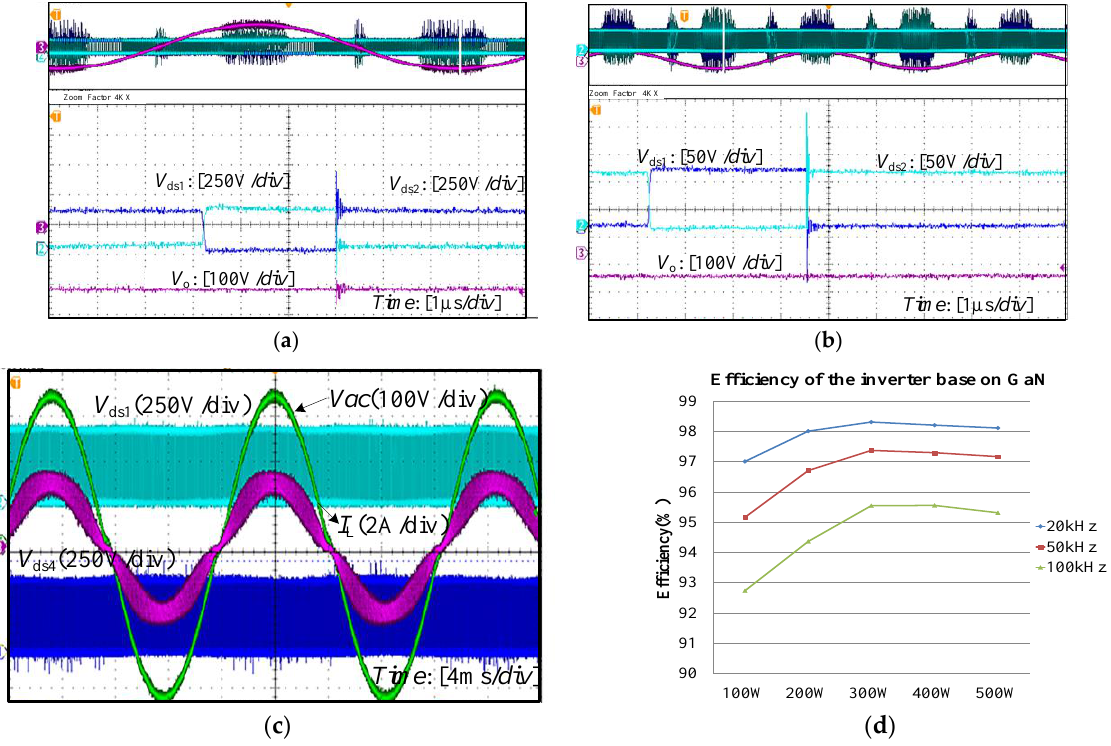
Figure 7. Experiment results of the cascode GaN HEMT-based single-phase inverter. ( a ) Experiment results of the cascode GaN HEMT-based inverter with L S = 5 nH; ( b ) Experiment results of the cascode GaN HEMT-based inverter with L S = 20 nH; ( c ) Experiment results of the cascode GaN HEMT-based inverter with full load; ( d ) Efficiency curve of cascode GaN HEMT based single-phase inverter.